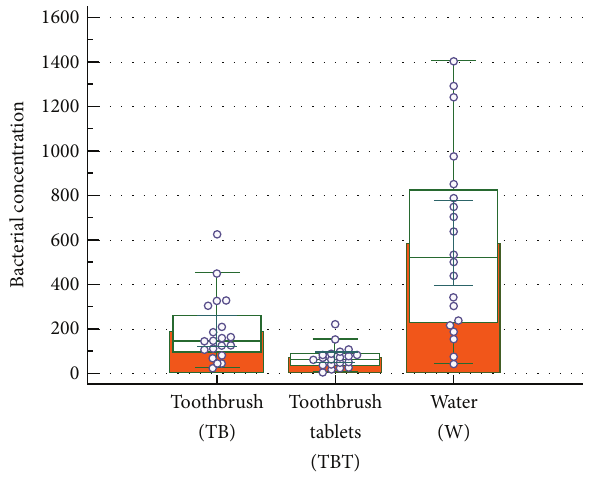
Figure 2: Box plot comparison between TB, TBT, and W. The graphical representation box and whiskers plot shown above, using the multiple comparison mode, is used to describe the distribution of a sample by means of simple measures of dispersion and location. The central box represents the values from the lower to upper quartile (25 to 75 percentile). The middle line represents the median. A line extends from the minimum to the maximum value, excluding “outside” and “far out” values which are displayed as separated